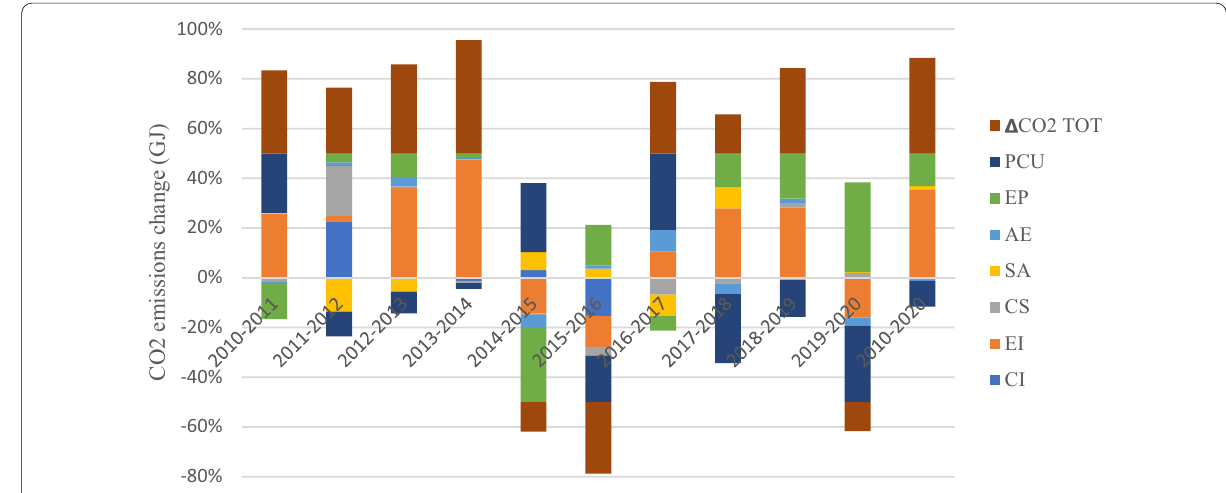
Fig. 11 Drivers of the change in CO 2